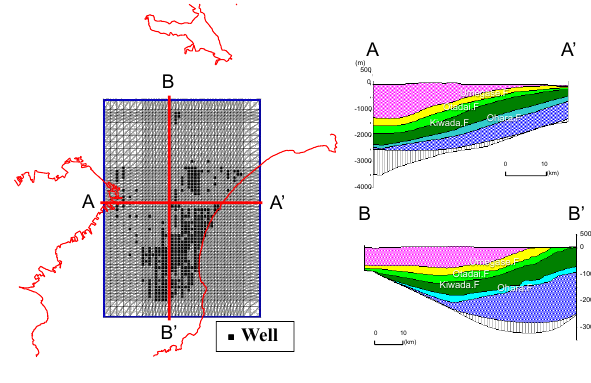
Figure 2. Simulation model.